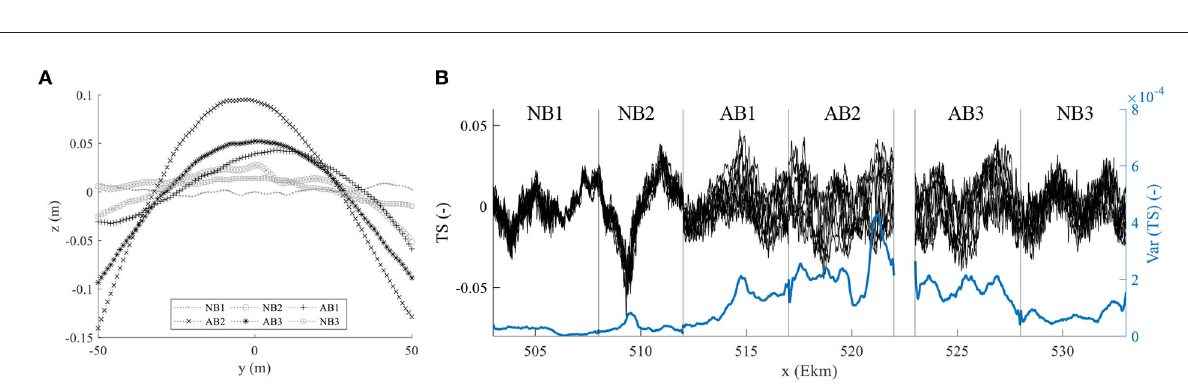
FIGURE6 (A) Temporal and longitudinal averaged bed elevations z of the different sections plotted over the bed width y, and (B) transverse slope (TS) and the temporal varaince of the TS of all years and sections plottet along the river